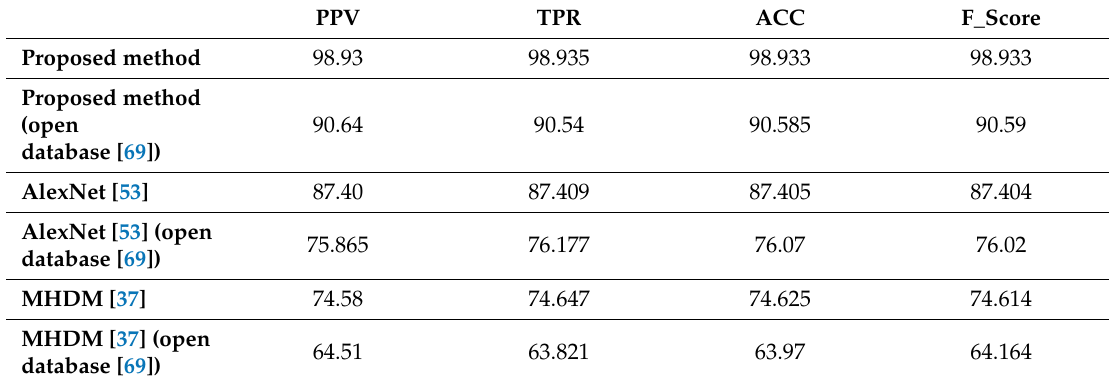
Table 14. Comparison of PPV, true positive rate (TPR), ACC, and F_score of proposed and previous methods